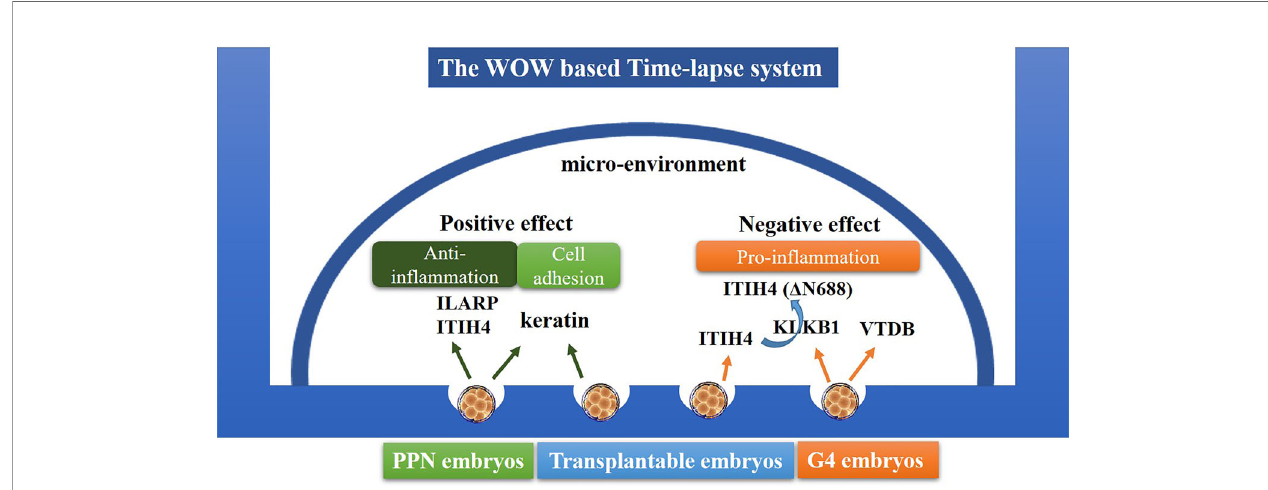
FIGURE 3 | Schematic diagram of the interaction between embryos through autocrine/paracrine proteins. In the WOW-based TLS, the PPN embryos need not be removed, and the embryos, co-cultured with PPN embryos, may bene fi t through the ILIAP, ITI-H4, and keratins secreted from the PPN embryos. The G4 embryos (except PPN-derived) would do harm to the development of other embryos through KLKB1 and VTDB